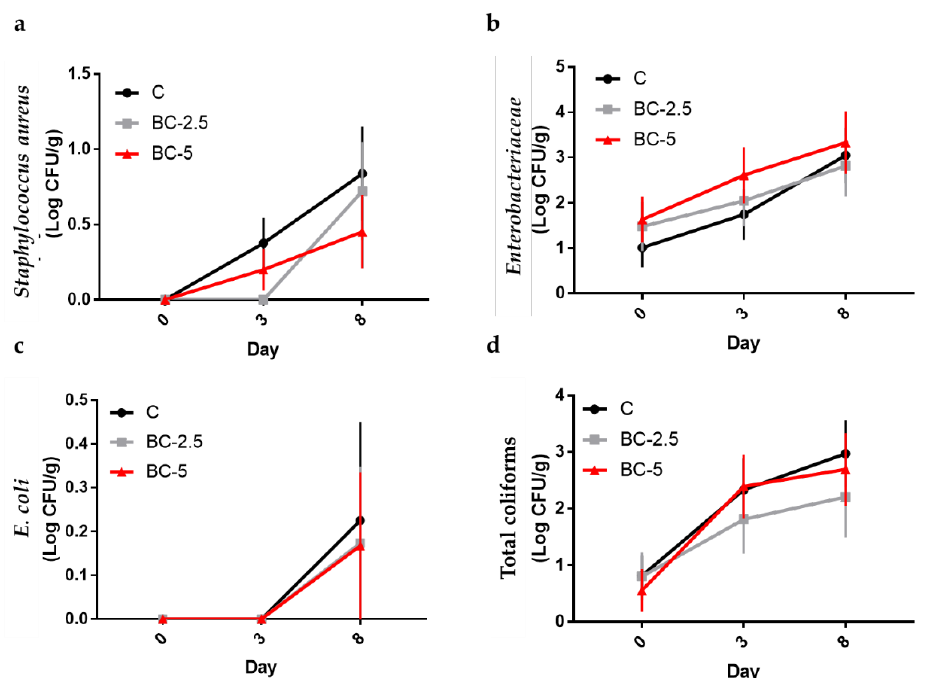
Figure 2. Effects of colostrum inclusion in the diet of rabbits on counts of Staphylococcus aureus ( a ), Enterobacteriaceae ( b ), E. coli ( c ), and total coliforms ( d ) on meat at 48 h postmortem (day 0) and at days 3 and 8 of shelf-life. C = control diet; BC-2.5 = diet supplemented with 2.5% bovine colostrum; BC-5 = diet supplemented with 5% bovine colostrum. The graphs show the mean ± standard error.